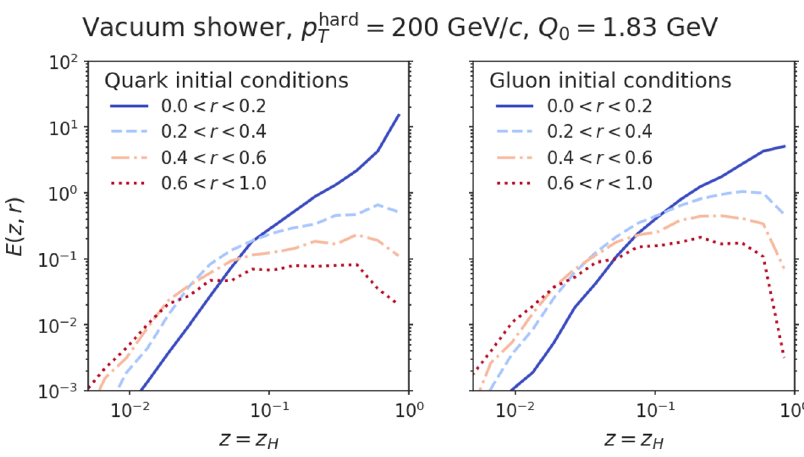
Figure 6 . E ( z H , r ) after vacuum parton shower evolution down to Q 0 .